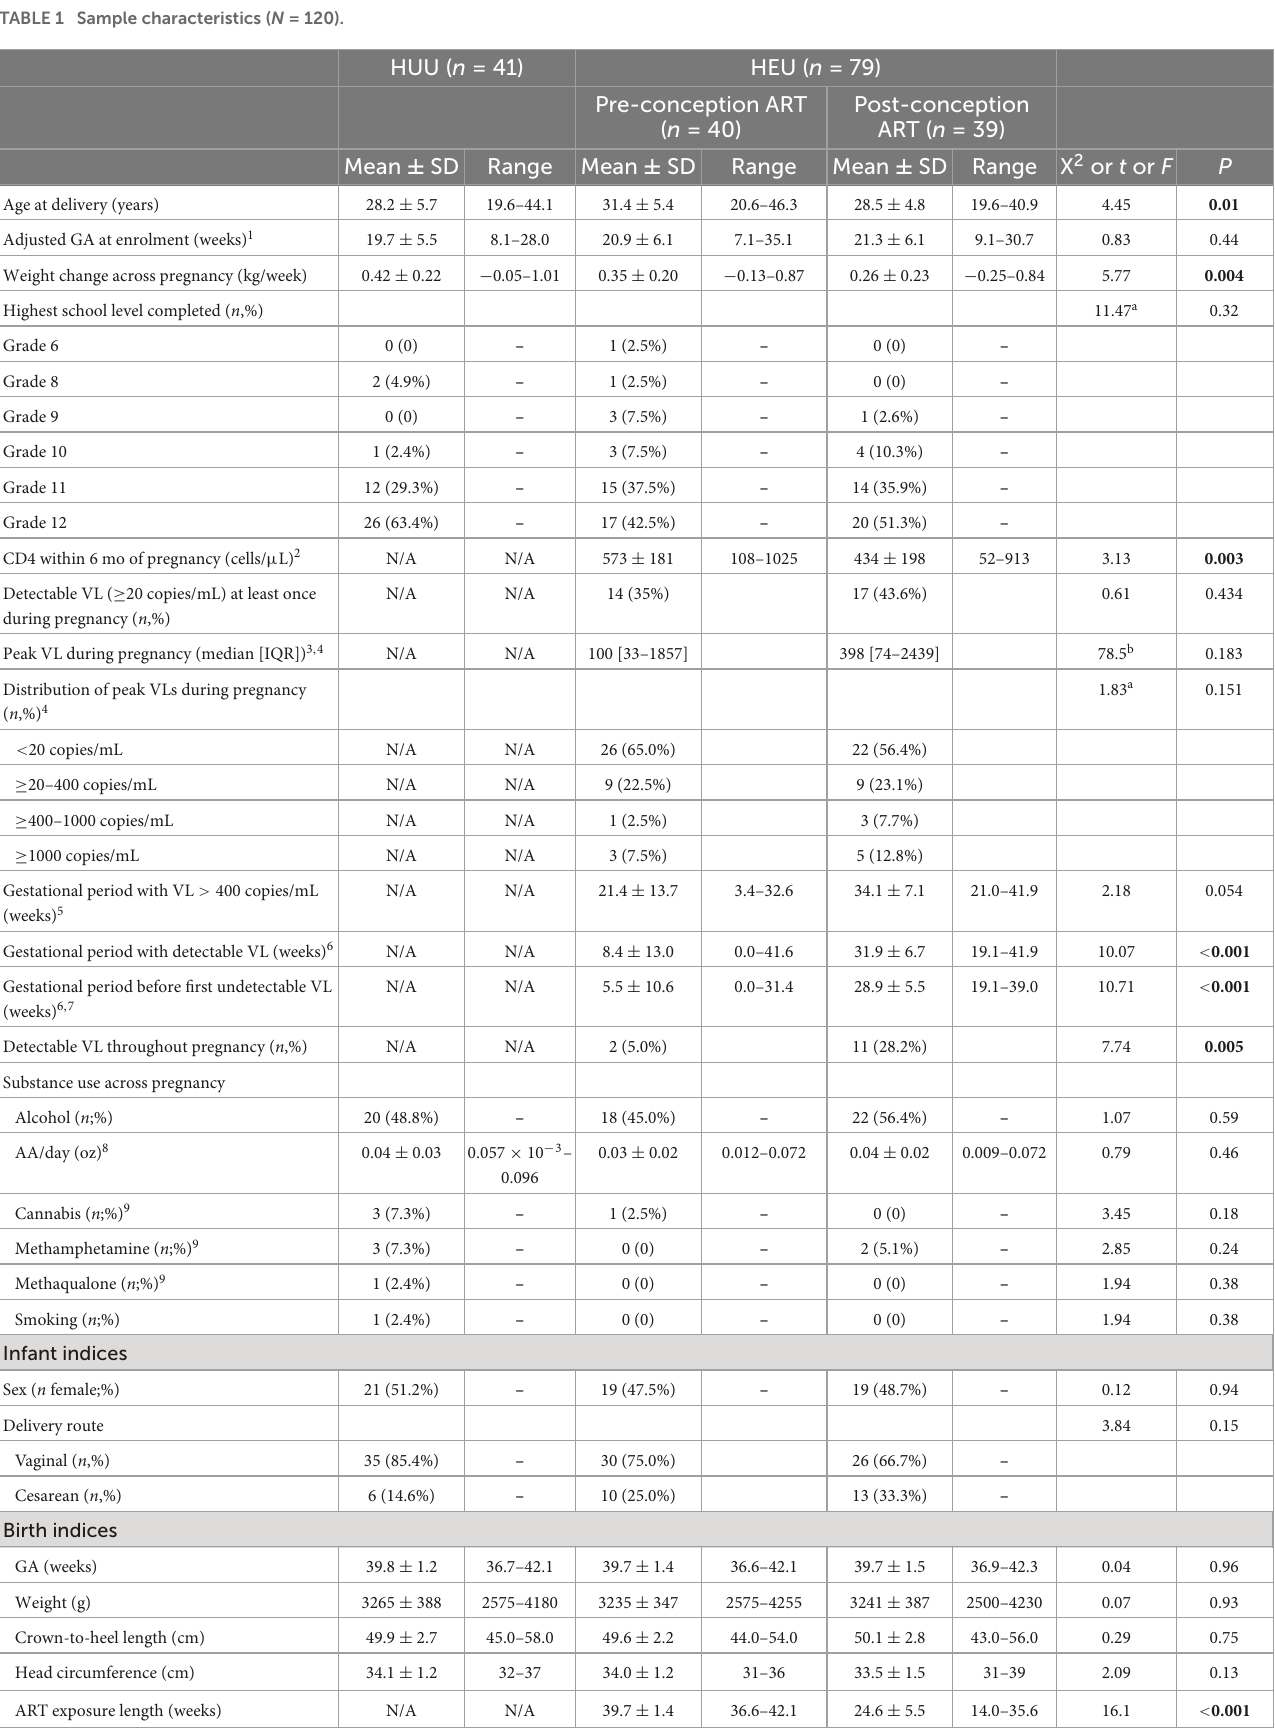
TABLE 1 Sample characteristics ( N =